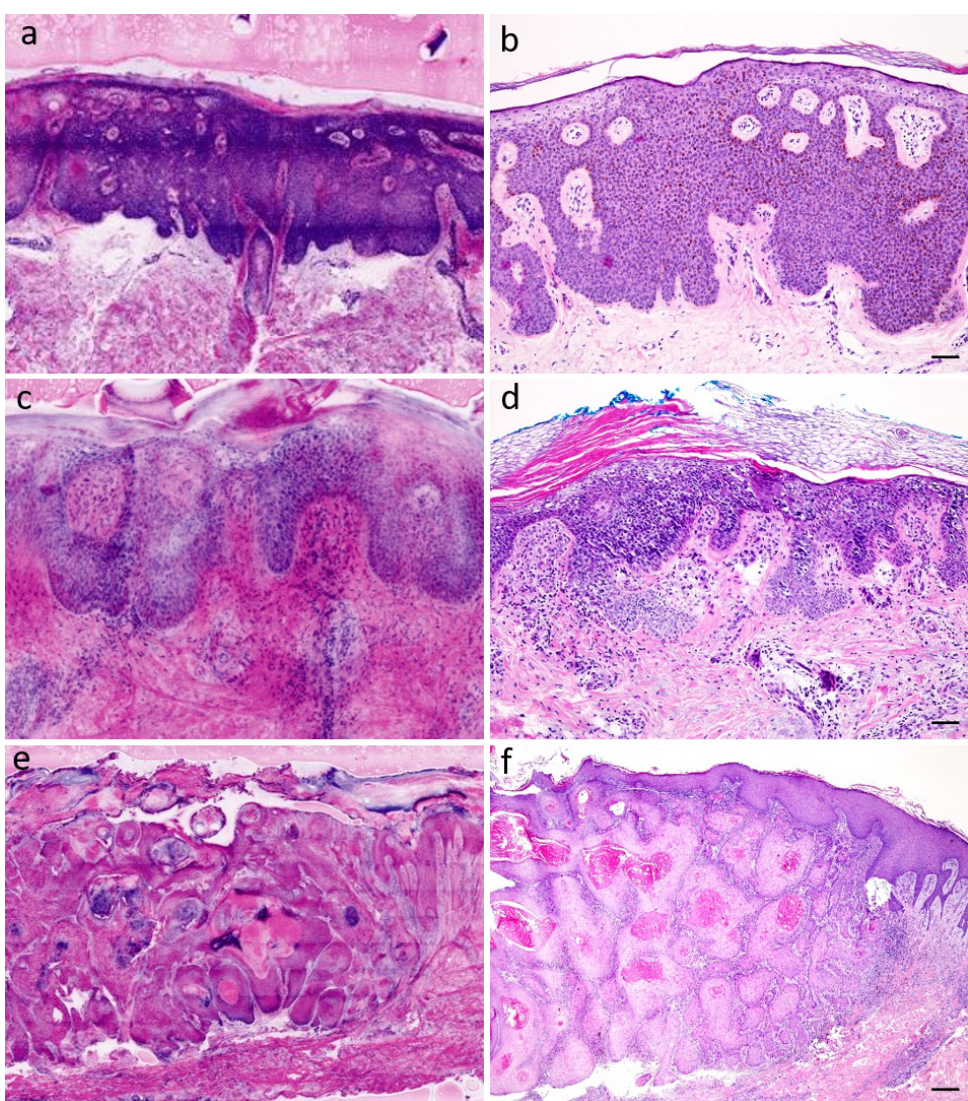
Figure 1. Epithelial tumors ( a ) seborrheic keratosis, CLSM ( b ) seborrheic keratosis, H&E-stain, scale = 250 µm. ( c ) Bowen’s disease (squamous cell carcinoma in situ), CLSM ( d ) Bowen’s disease, H&E-stain, scale = 100 µm ( e ) highly differentiated squamous cell carcinoma (SCC, G1), CLSM ( f ) SCC, G1, H&E-stain, scale = 500 µm.